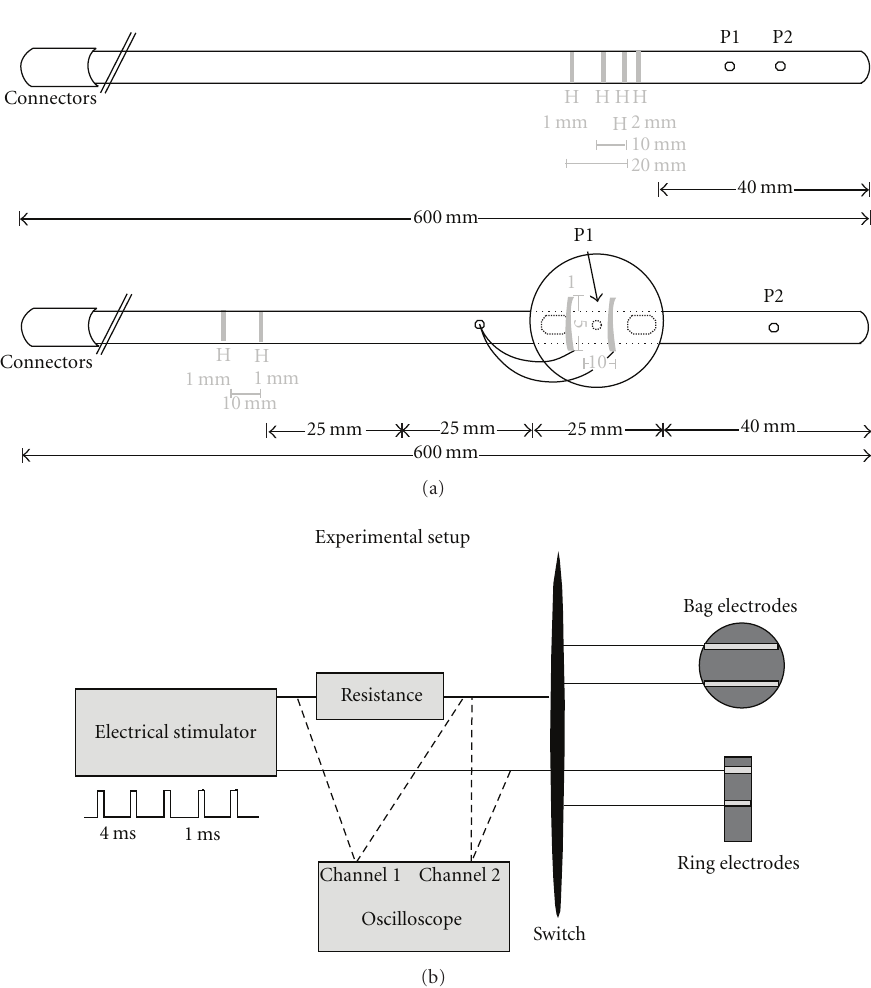
Figure 1: (a) Catheter was developed and designed to compare electrical stimulation with ring electrodes placed on the catheter using di ff erent electrode distances. Another catheter was designed for comparison of electrical stimulation with ring electrodes placed on the catheter and patch electrodes placed on a small inflatable bag. (b) The experimental setup. The potential across a known resistance was measured as U1 to verify the output of the electrical stimulator. The verified current intensity was used to calculate the transmural impedance of the total esophageal wall from the measured potential U2. P1 and P2 are pressure recording sites on the